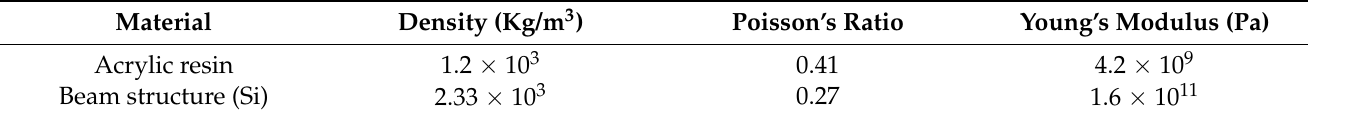
Figure 4. ( a ) Microstructure model for sensor; ( b ) integrated microstructure model of concave cilium; ( c ) microstructure model of concave cilium. Table 2. Material attributes. Table 2. Material attributes.